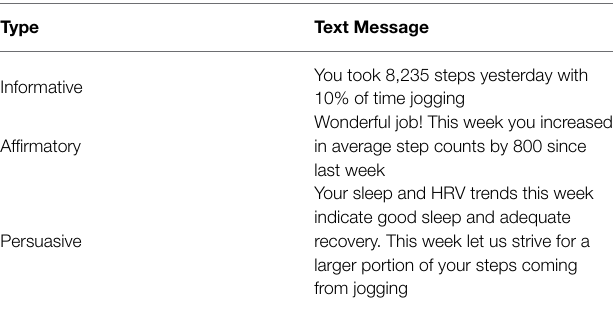
TABLE 1 | Examples of guided text message-based feedback (GTF) for participant activity utilizing positive reinforcement techniques including informative, affirmatory, and persuasive content (i.e.,